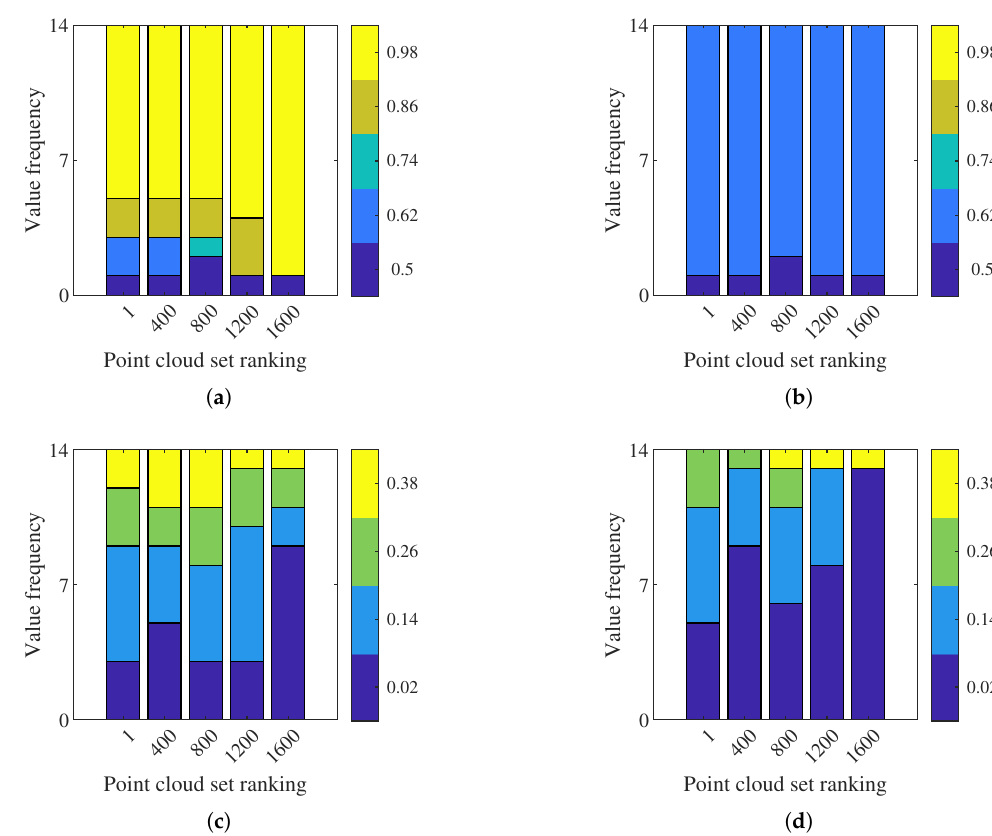
Figure 7. Frequency of optimal values of OctoMap parameters against point cloud set ranking on training data sets. ( a ) 𝑝 . ( b ) 𝑝 ℎ . ( c ) 𝑝 𝑚 . ( d ) 𝑝 . max min